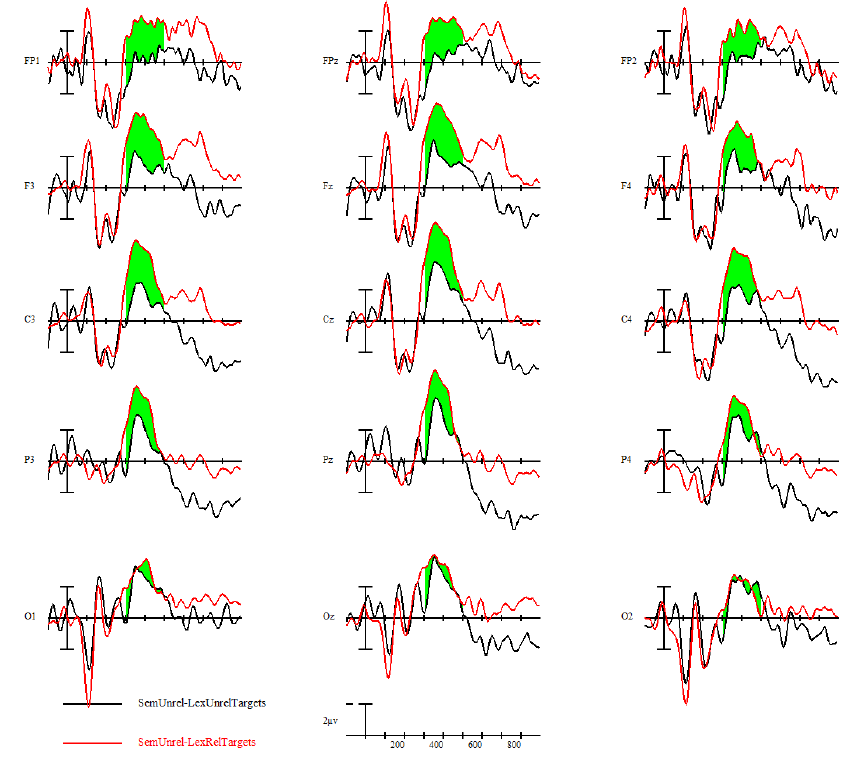
Figure 12. L1 translation lexical priming effect in high-attrition bilinguals ( N = 8).